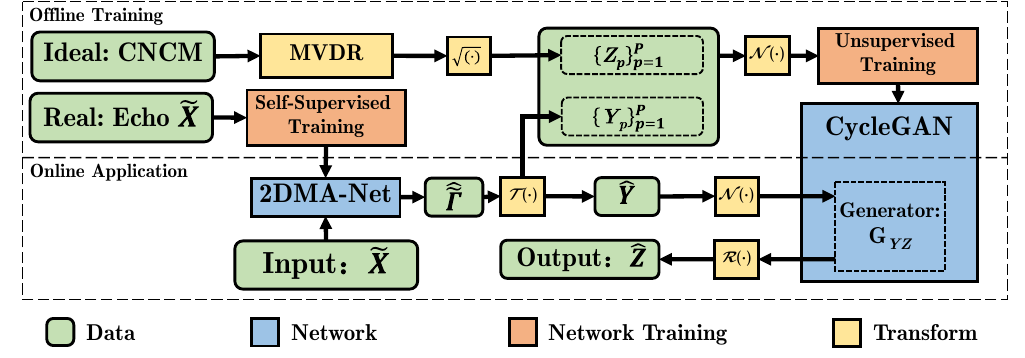
Figure 2. Processing framework of DU-CG-STAP.